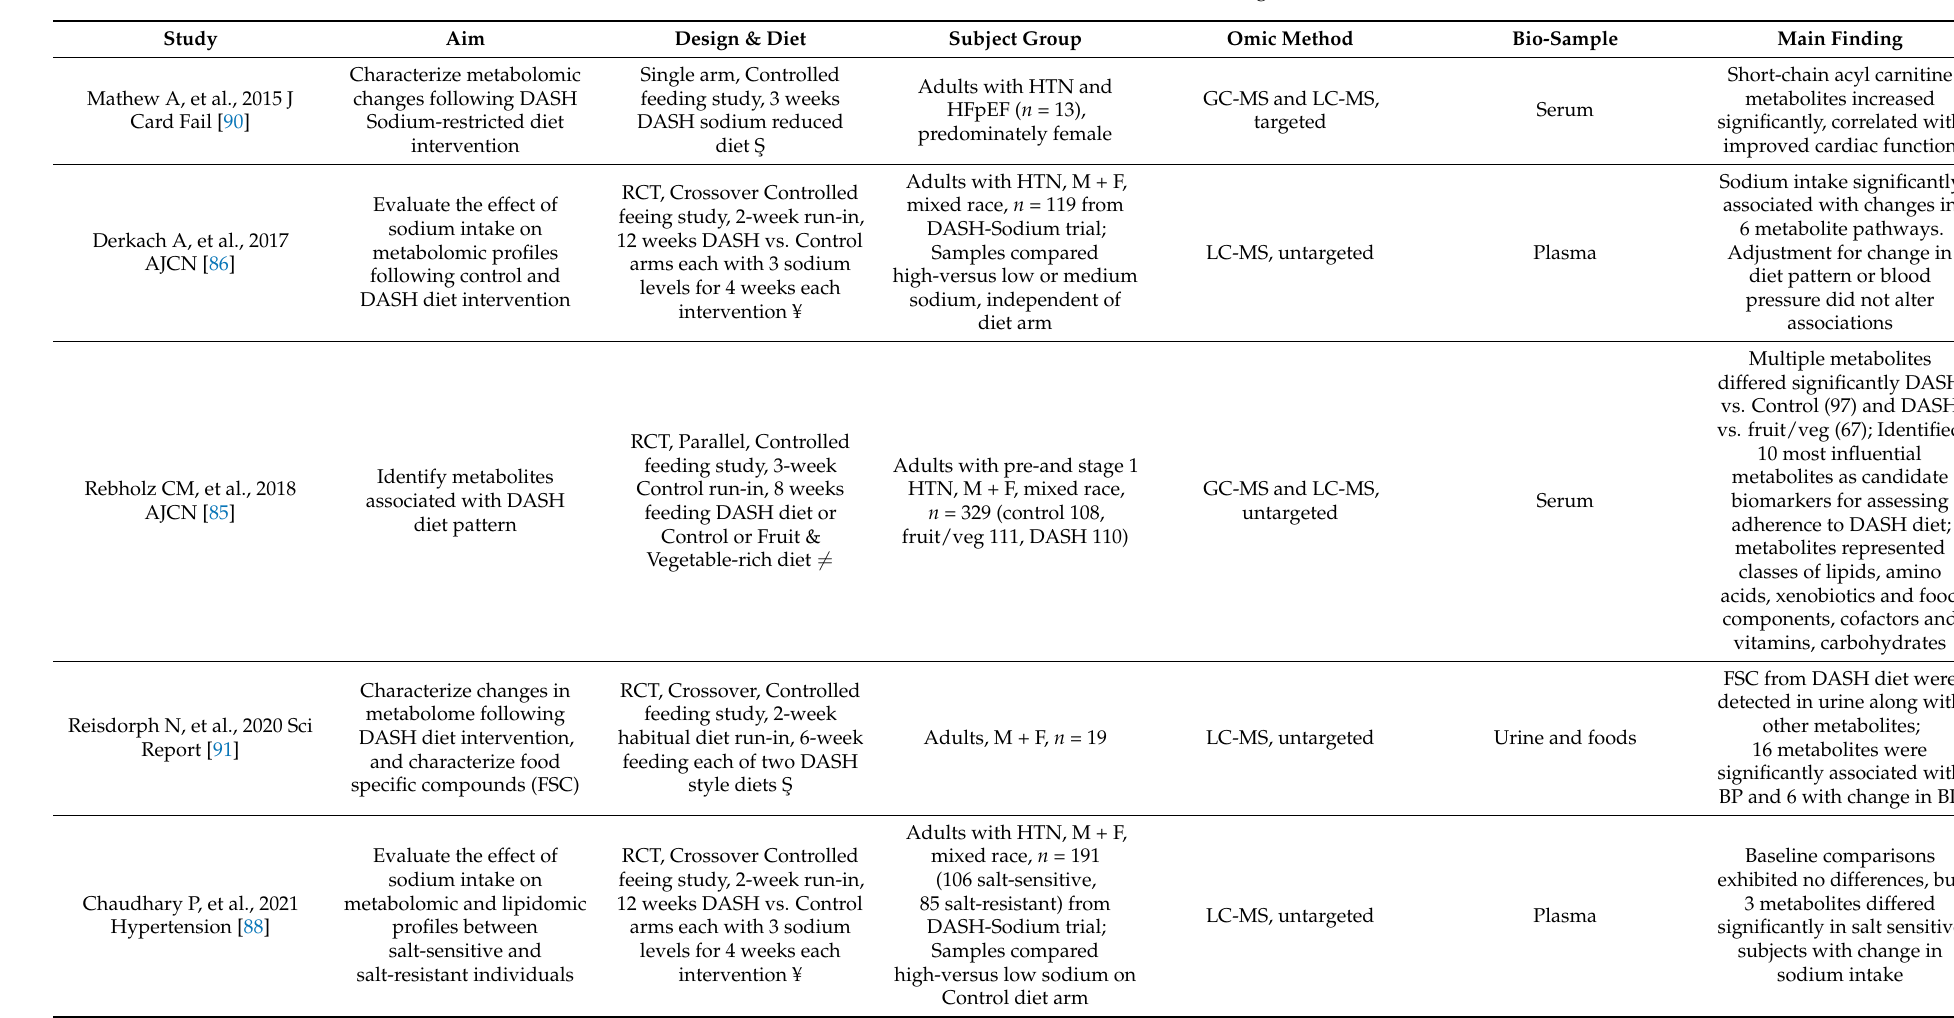
Table 1. Metabolite markers associated with DASH feeding